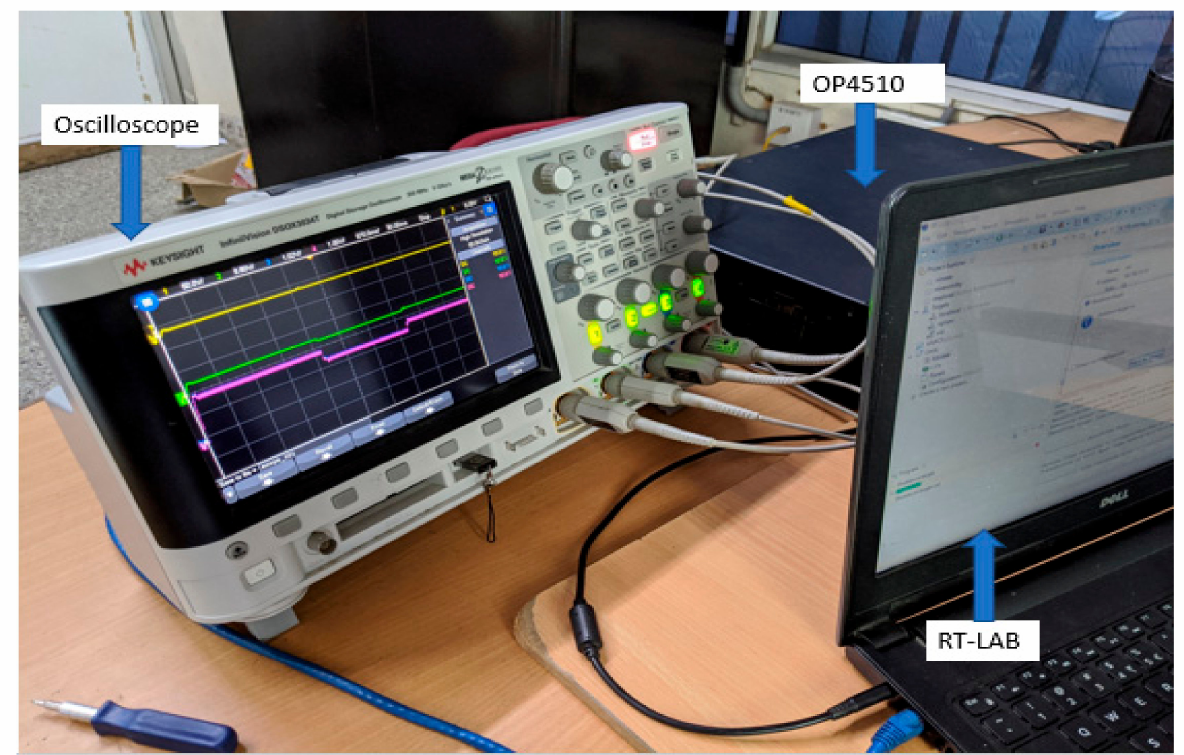
Figure 15. HIL real-time simulator setup.